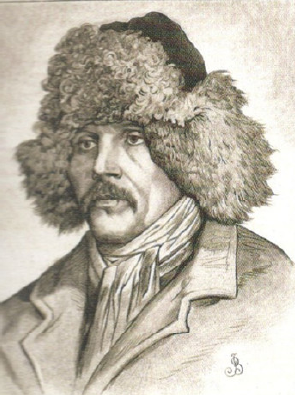
Figure 6. A resident from the Vilnius government Švenčionys district [56].